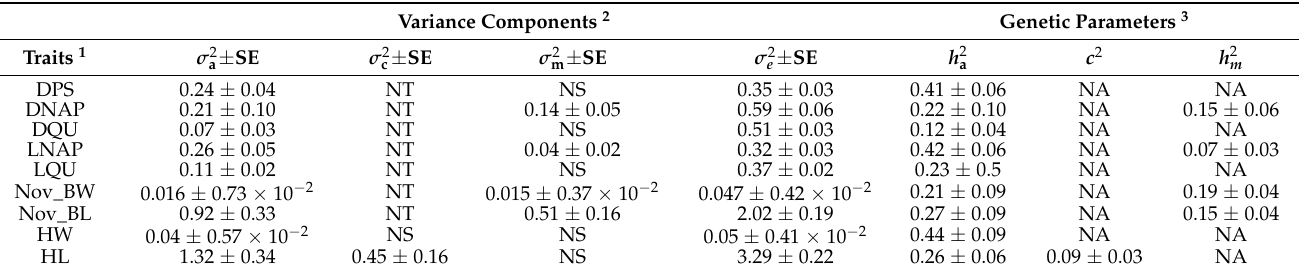
Table 3. Variance components and heritabilities ( ± SE ) estimated using univariate models for dried pelt traits, live grading and body weight and length traits in mink.